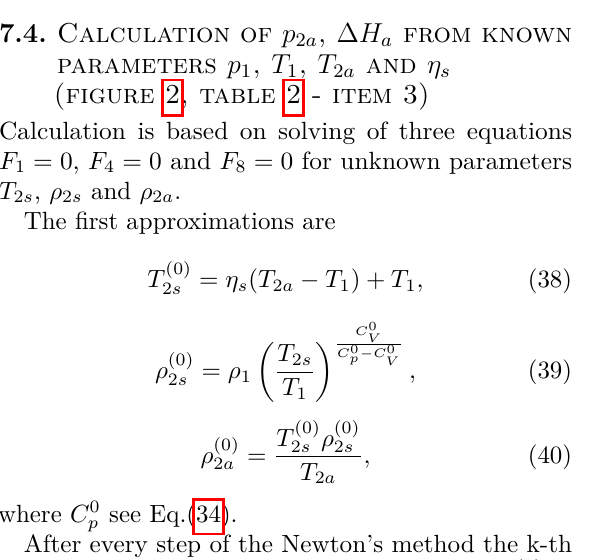
Figure 4. Ideal gas temperature T Eq. (30) – blue curve and real gas temperature T 2 s – red curve. Inlet conditions propane p 1 = 550000 Pa, T 1 = 293 . 15 K.